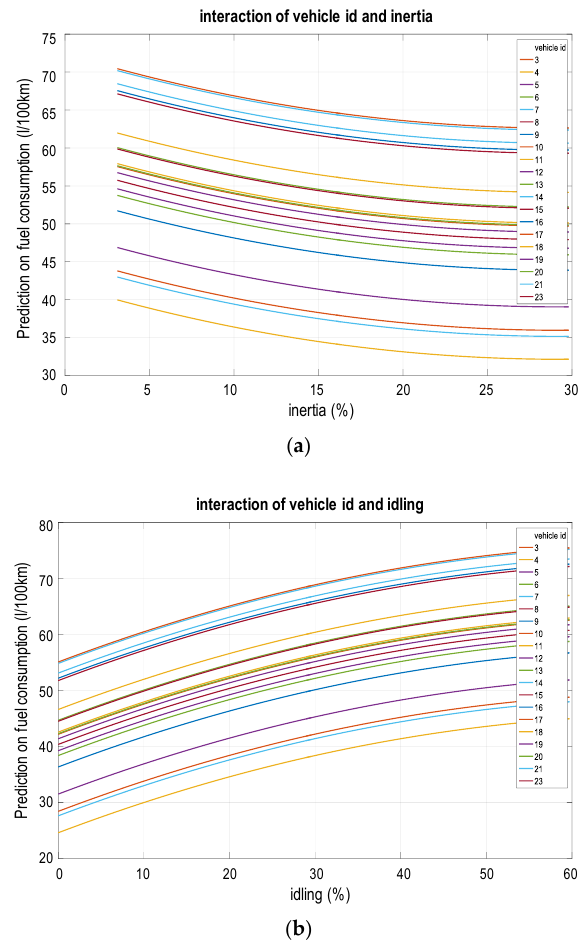
Figure 10. Effect on changing inertia and idling for the evaluated buses. ( a ) Effect on changing inertia; ( b ) Effect on changing idling.